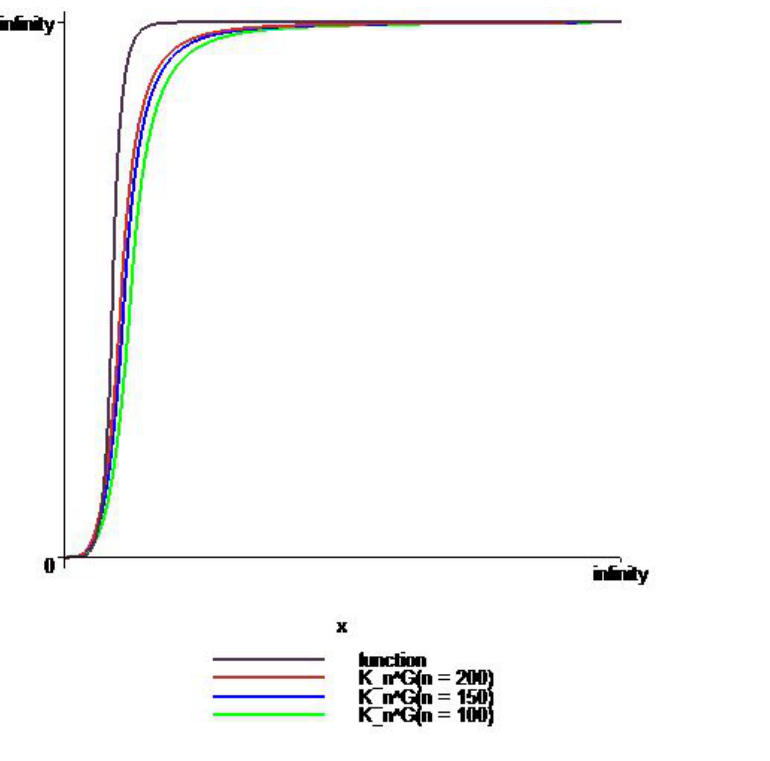
Figure 2. Approximation by K G (violet) on [ 0, ∞ ) for ρ n = n − 1/20 , such that τ n = n ρ n , i.e., τ n = n 19/20 and β n = 1 + 50 n − 1